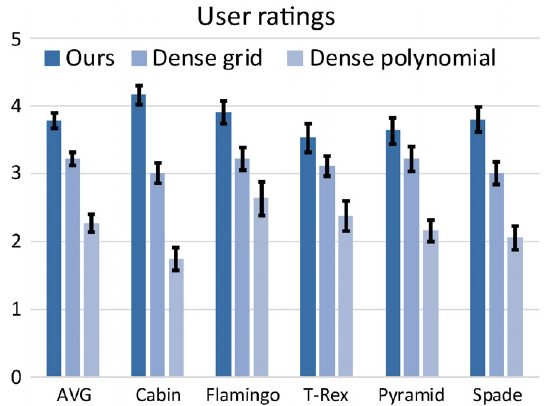
Fig. 10 User ratings for image mosaics produced using three different approaches. Error bars represent the standard error in the mean.